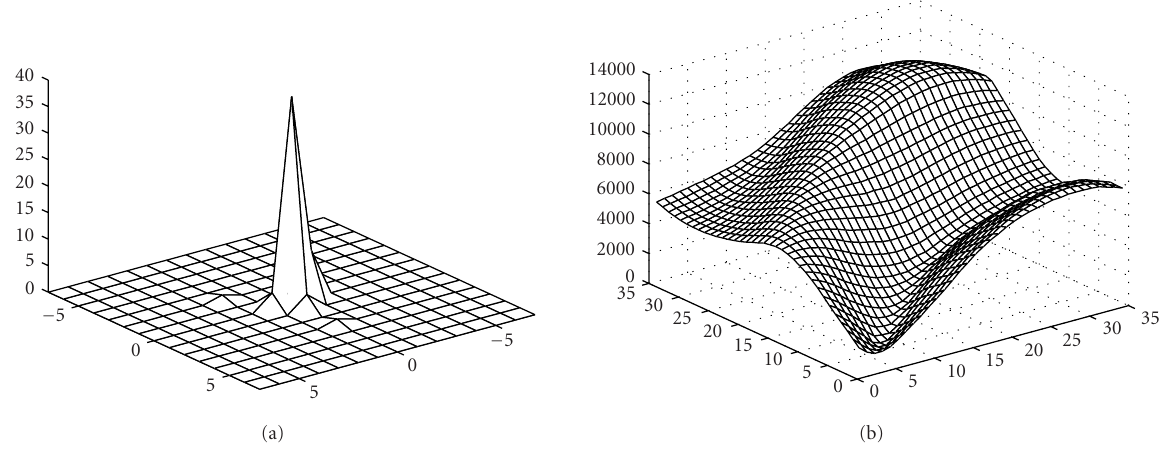
Figure 2: The basic properties of the block motion fields and the SAD distribution: (a) center-biased motion vector distribution character- istic and (b) spacial direction SAD distribution